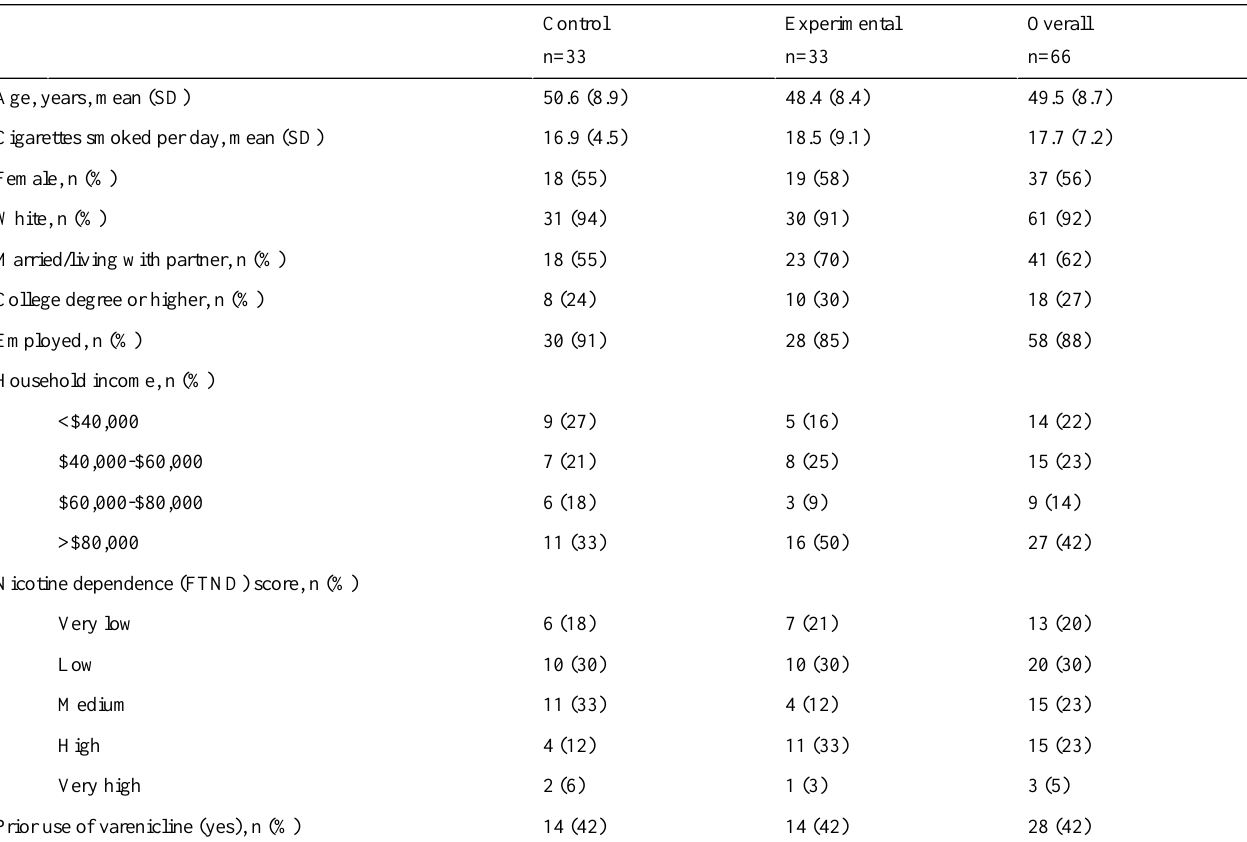
Table 1. Baseline characteristics.